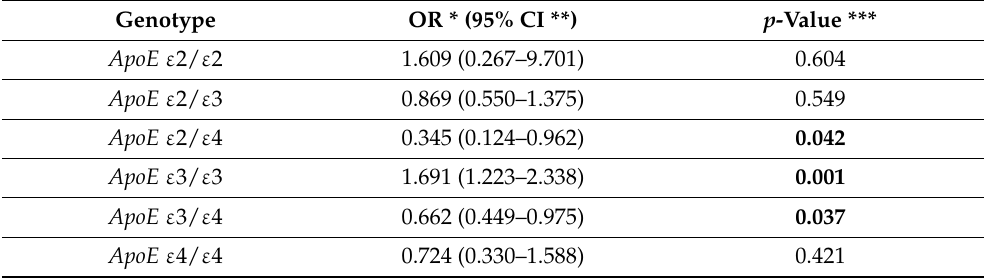
Table 3. Binary logistic regression analysis of ApoE .